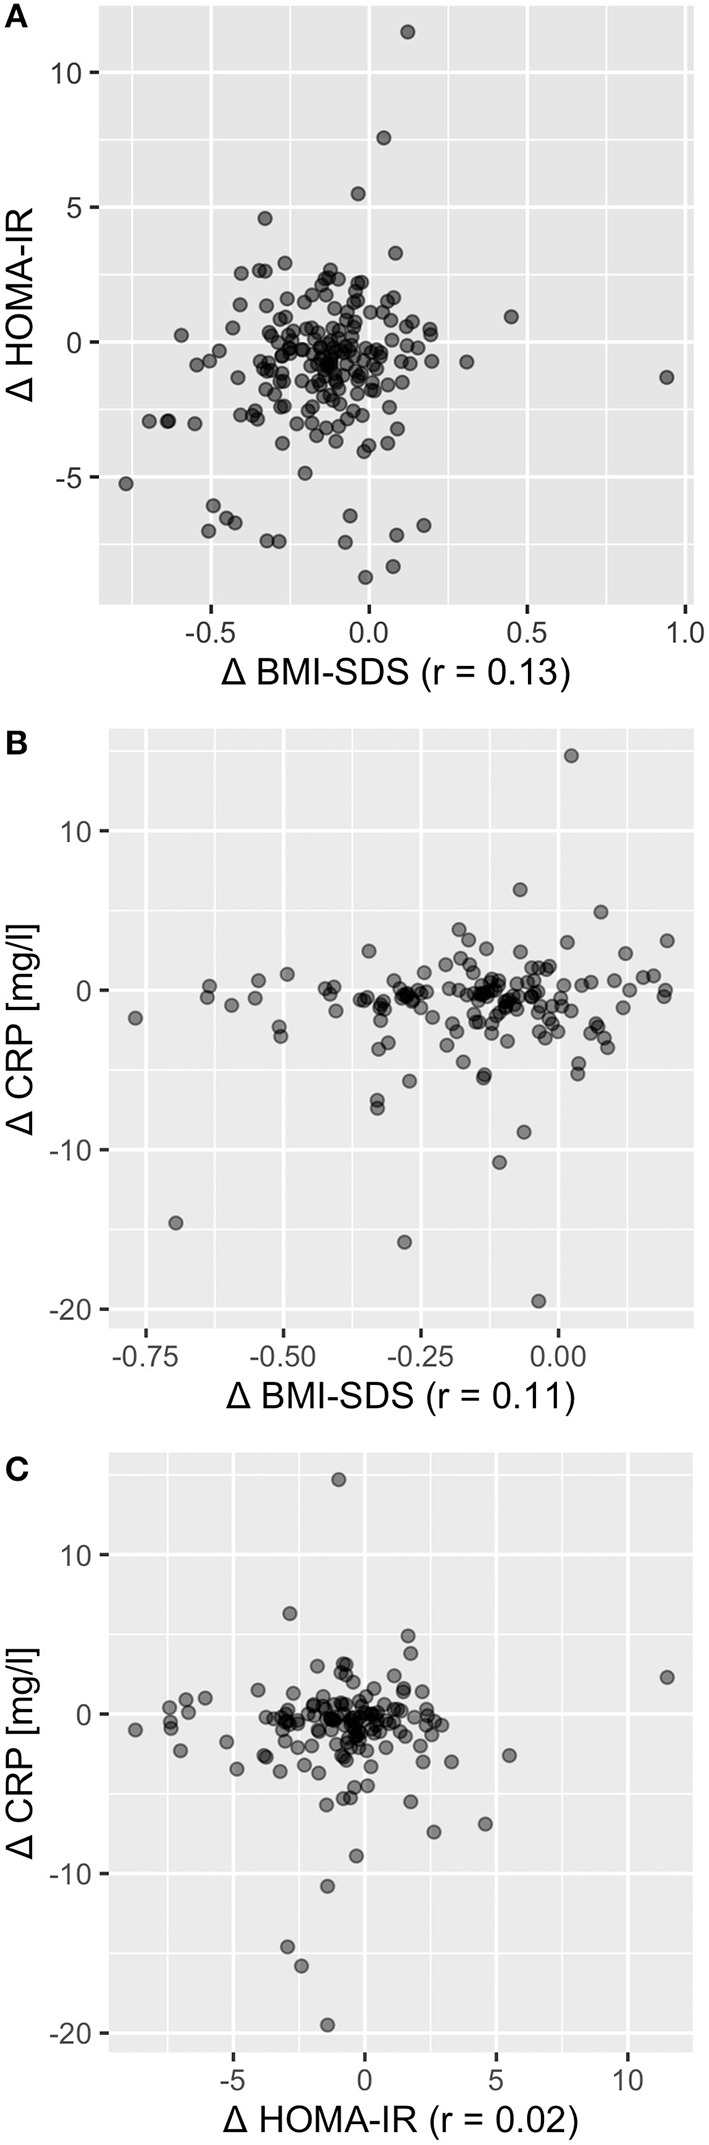
Change in BMI-SDS, HOMA-IR, and CRP were largely independent from each other. Correlation coefficient for Δ BMI-SDS with Δ HOMA-IR was r = 0.13 (A), for Δ BMI-SDS with Δ CRP r = 0.11 (B), and for Δ HOMA-IR with Δ CRP r = 0.02 (C), indicating independency of change in BMI, insulin resistance, and metaflammation.